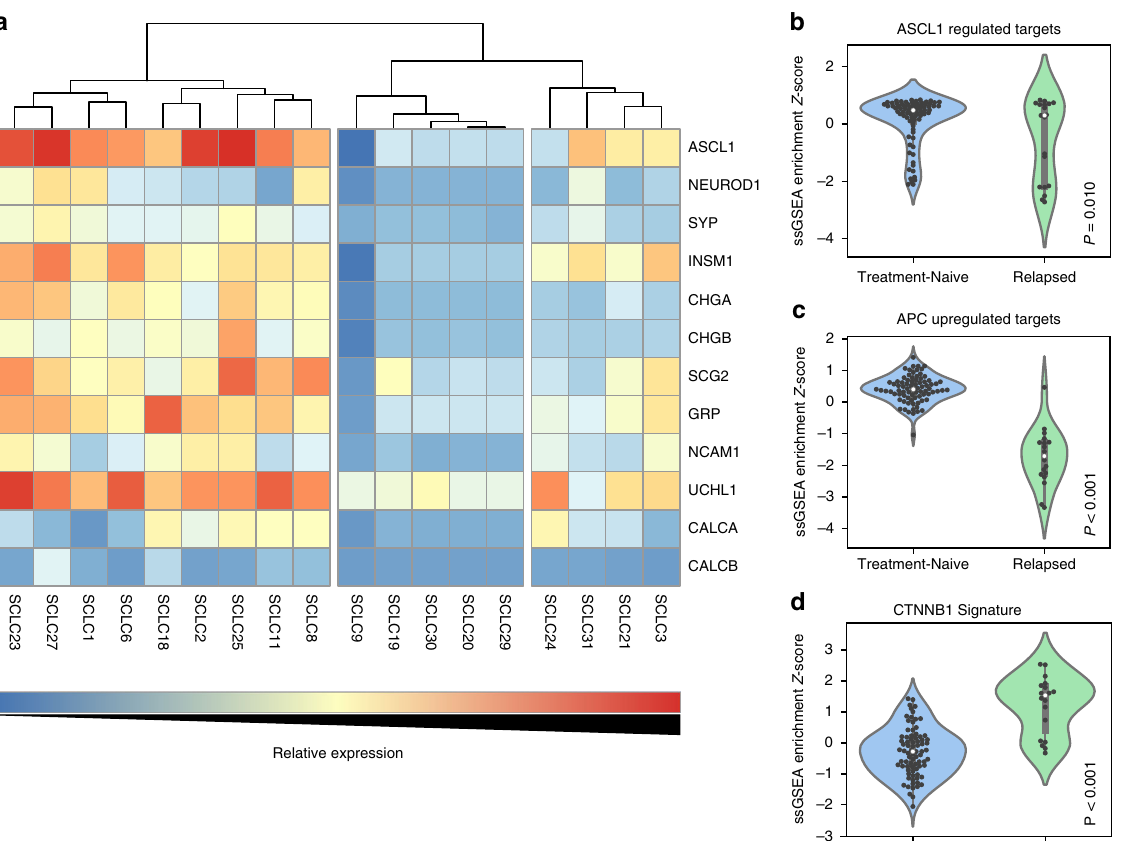
Fig. 2 Relapsed human SCLC samples are enriched for ASCL1-low subtype and show a higher level of WNT activity. a Categorization of relapsed SCLC into ASCL1-high (left), NEUROD1-high (right), and ASCL1 and NEUROD1-low (dual negative; center) expression sub-types. Overall, our cohort of relapsed samples was enriched for ASCL1-low samples, when compared to treatment-naive samples that were sequenced in other studies (50% vs. 18%; p = 0.01, Fisher ’ s exact test). Violin plots demonstrating differential ssGSEA enrichment scores between relapsed samples and treatment-naive SCLC samples (George et al.) for b ASCL1 (Borromeo et al. signature) and WNT pathway activation using c APC upregulated targets from Lin et al. and d CTNNB1 oncogenic signature from Bild et al. Gray boxes represent quartiles encompassing the mean (white dot), and whiskers extend to all data points within 1.5 interquartile range (IQR). Individual data points are overlaid as black dots. Unpaired Student ’ s t test was used to calculate two-tailed p values. Color scale for a increases from blue (low relative expression) to red (high relative